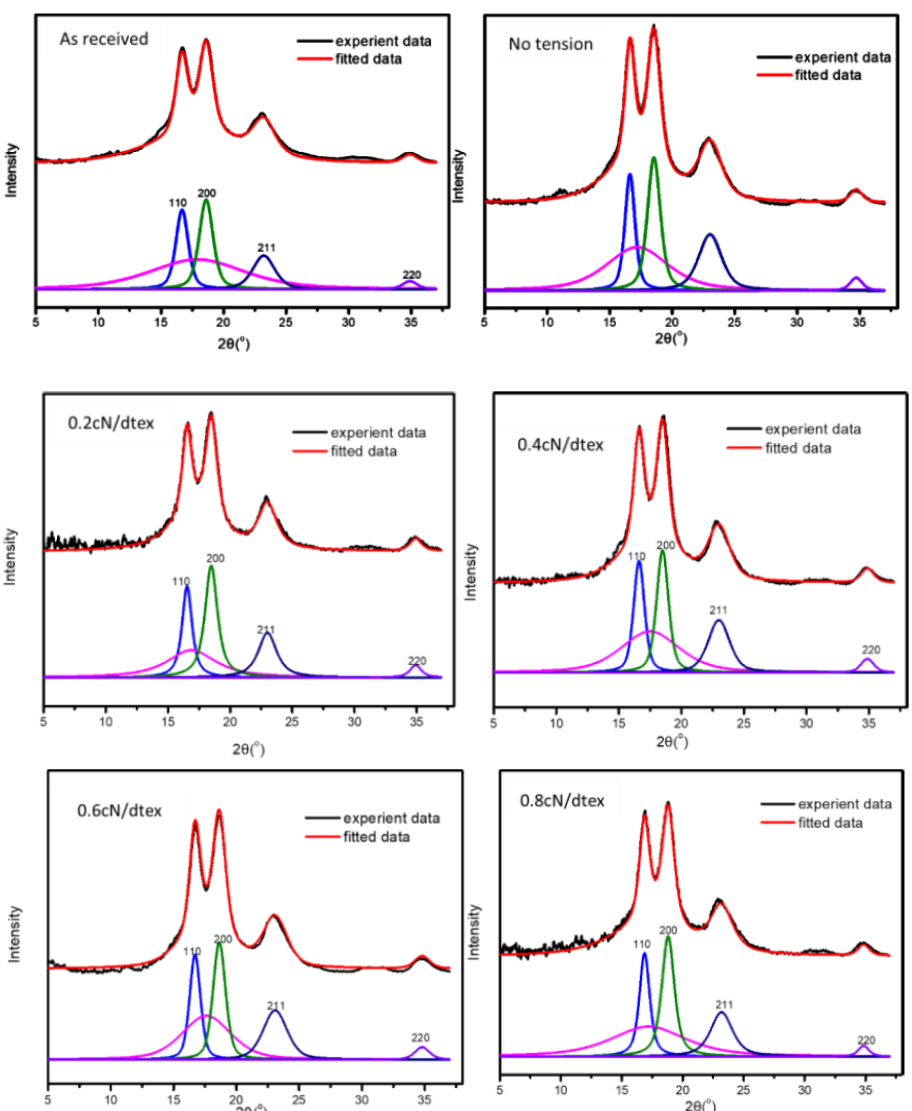
Figure 7. WAXD peaks fitting results for the Kevlar 49 fibers treated in different conditions.